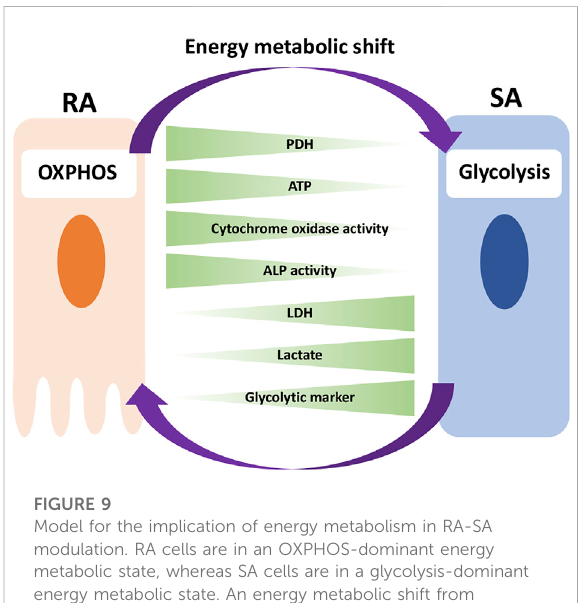
FIGURE 9 Model for the implication of energy metabolism in RA-SA modulation. RA cells are in an OXPHOS-dominant energy metabolic state, whereas SA cells are in a glycolysis-dominant energy metabolic state. An energy metabolic shift from OXPHOS to glycolysis decreases the mineralization function of M-ABs, implying a phenotypic change from RA to